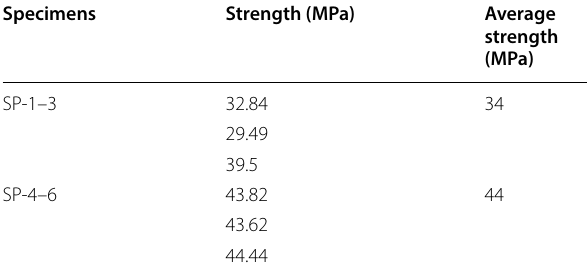
Table 2 Concrete compressive strength test.